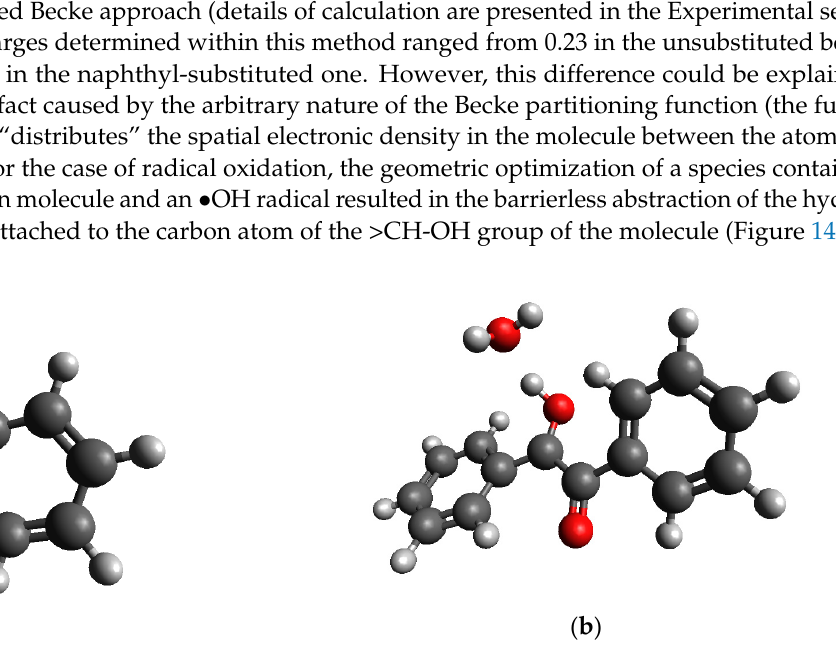
Figure 14. ( a ) Initial and ( b ) equilibrium (optimized by DFT) geometries of {benzoin+ •OH} species.